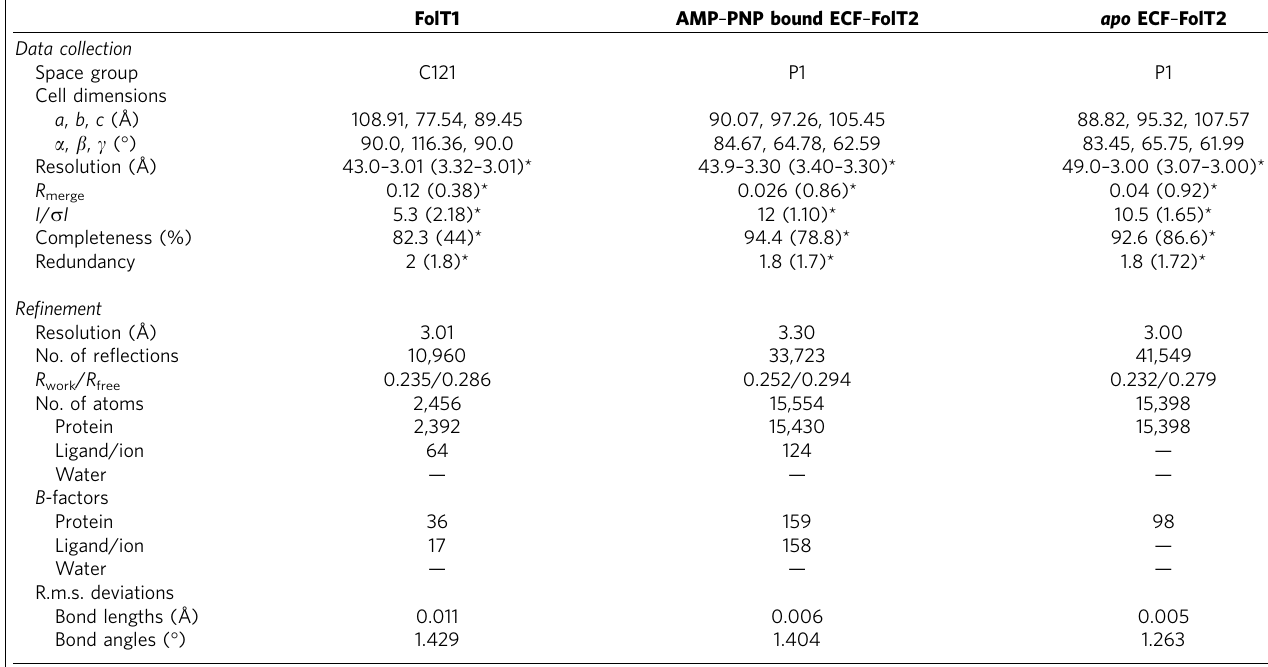
Table 1 | Data collection, phasing and refinement statistics.